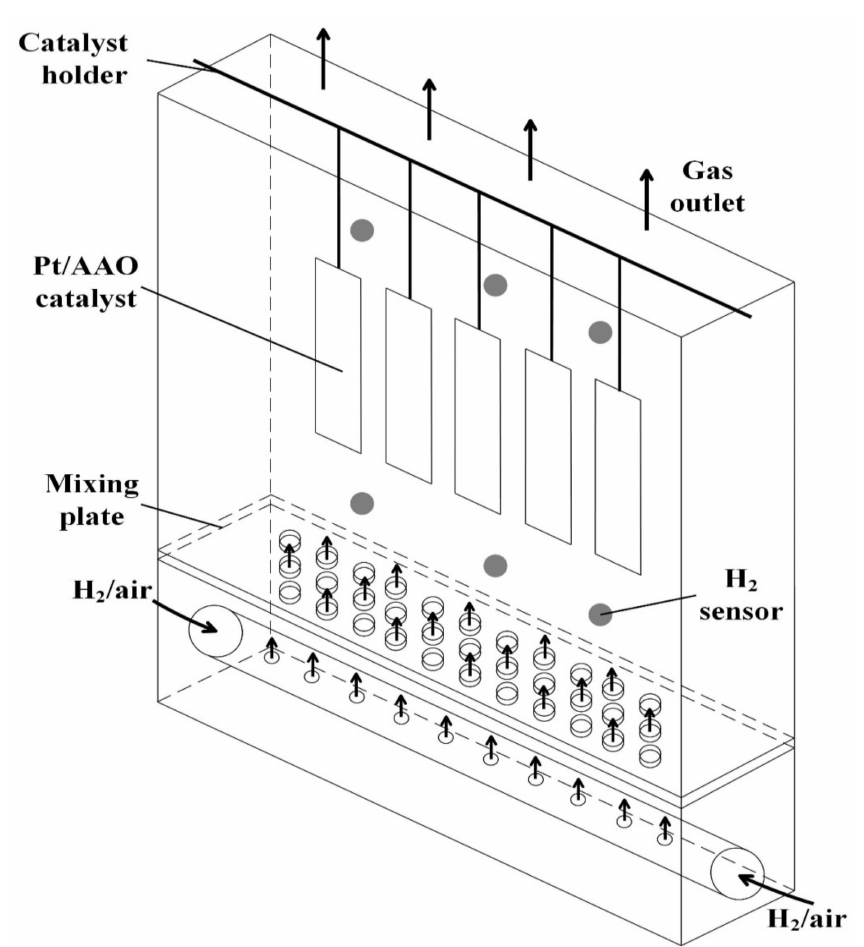
Figure 12. Schematic of the experimental setup used to determine the Pt/anodized aluminum oxide (AAO) catalytic activity and thermal distribution of the catalyst